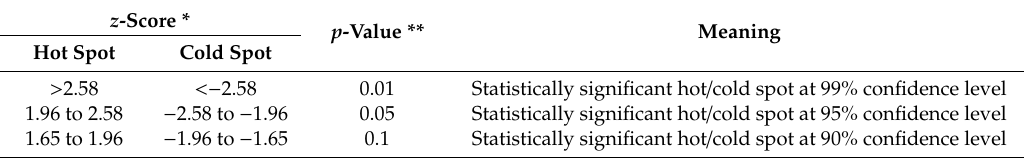
Table 2. Hot / cold spot classification.